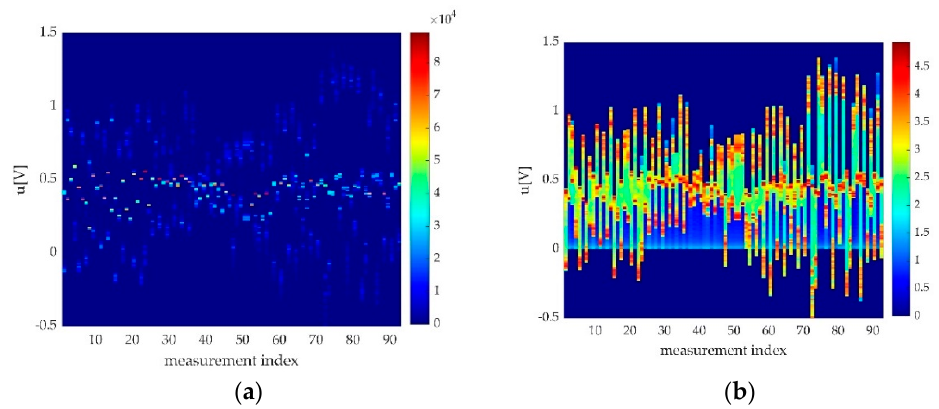
Figure 12. Histograms of measurement cohorts seemed from above colour-coded (histogram of histograms): ( a ) absolute value; ( b ) logarithmic representation.